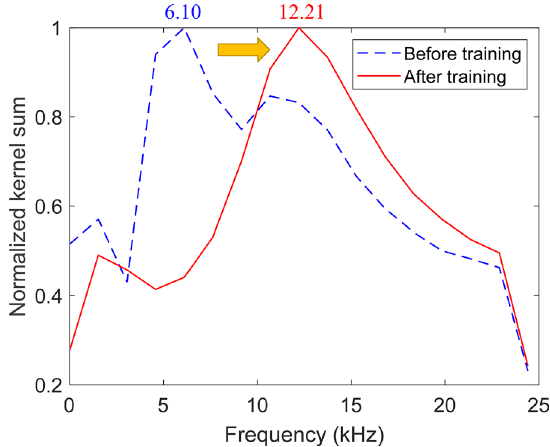
Figure 16 Cumulative frequency band of the wavelet convolution kernel